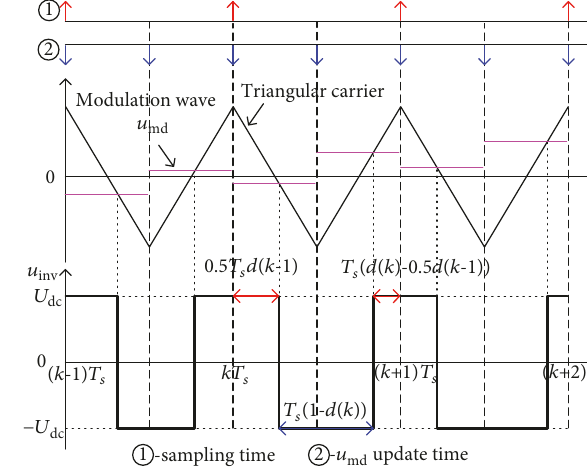
Figure 4: The double update PWM